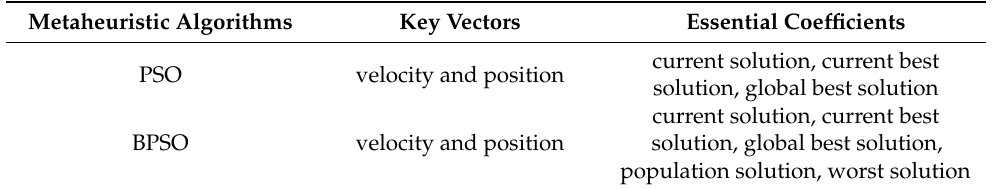
Table 2. Detailed comparative analysis of PSO and